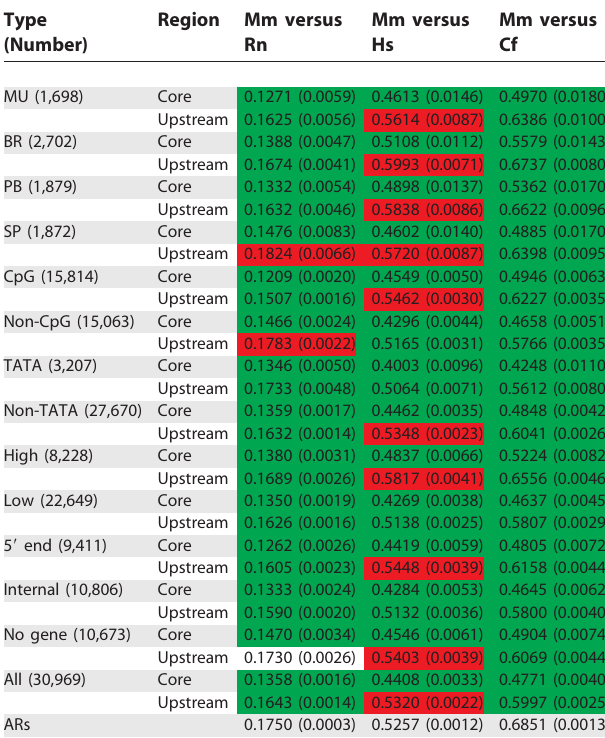
Table 1. Substitution Rate Estimates for Mouse Promoters Type Region Mm versus (Number) Rn